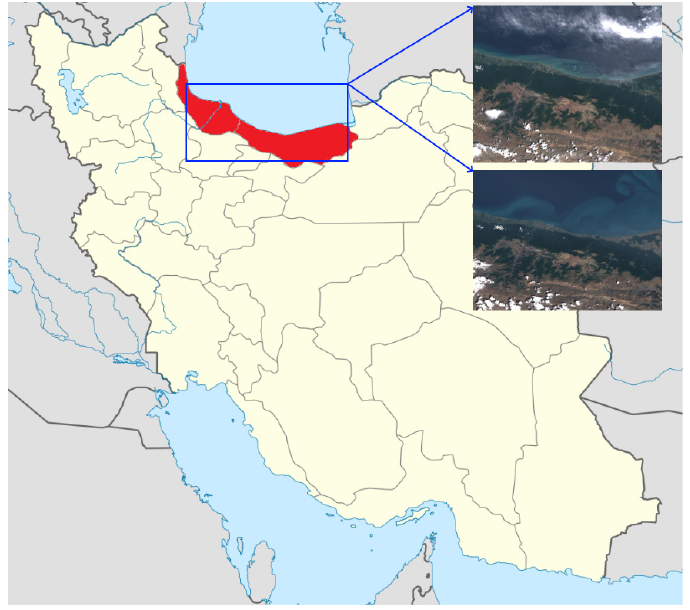
Figure 1. Map of study location in Iran ( red ), Sentinel ‐ 2 images of study location in 2017 ( top ) and 2021 ( bottom ).